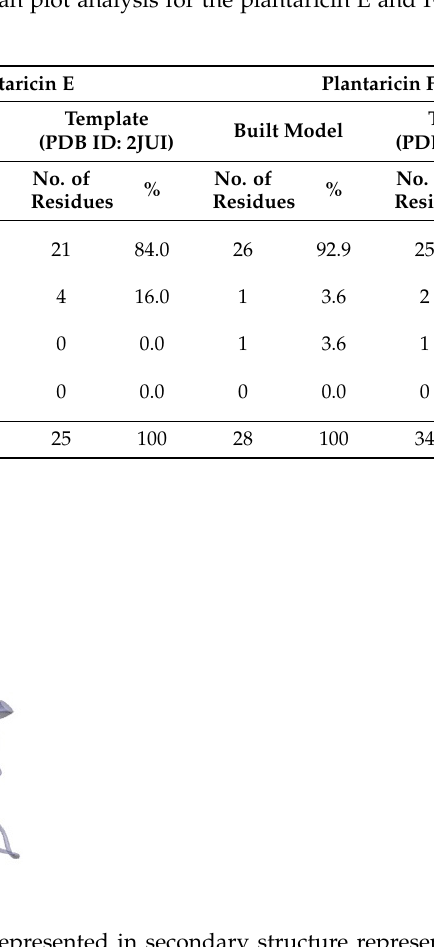
Figure 7. Molecular Docking of PlnE and PlnF. ( a ) The 3D structure of SARS-COV-2 helicase nsp 13 (PDB ID: 6ZSL) was used in the molecular docking studies. The built model for PlnE ( b ) and PlnF ( c ). The docked results shown that PlnE ( d ) and PlnF ( e ) were tucked into both the ss-RNA and the ATP binding site cavity.